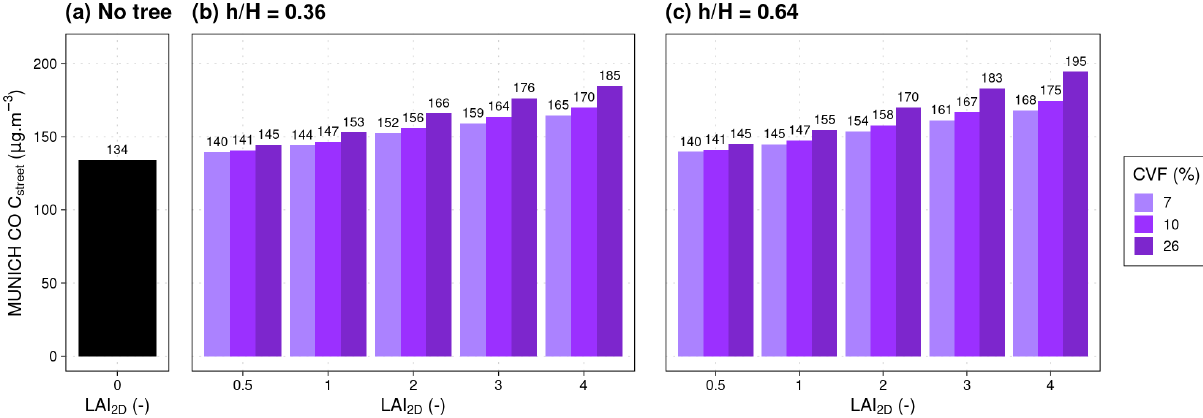
Figure D1. Comparison of CO concentration ( C street ) simulated with MUNICH in IC for different tree LAI 2D , CVF, and tree height ratios h/H . The graphic is divided into three columns corresponding to the treeless canyon (a) and to canyons with trees of height ratios h/H = 0 . 36 (b) and 0 . 64 (c) . The concentrations C street (in µgm − 3 ) are specified with data